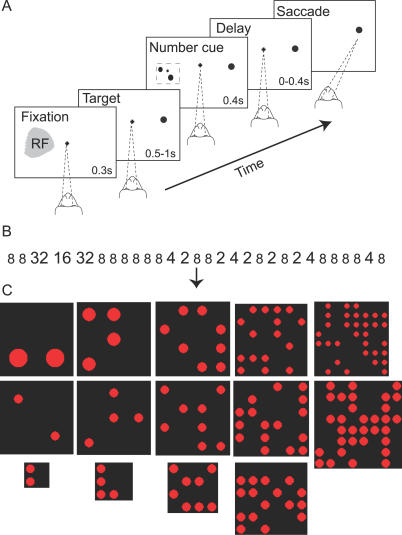
Implicit Numerical Discrimination Task(A) Sequence of trial events. The RF of the LIP neuron is first mapped using a delayed saccade task. Completion of each trial is followed by a fluid reward.(B) Sample trial sequence in which 8 is the standard numerosity and 2, 4, 16, and 32 are deviants. The standard is randomly presented on 50% of trials, and predicts a standard reward (0.1-ml fluid, indicated by smaller digit size). On the other trials, one of the deviant numerosities is shown, predicting a larger reward (0.15-ml fluid, larger digit size). Arrow identifies an example of numerosity that would be presented for an “8” trial.(C) Examples of dot arrays for the numerosities tested: 2, 4, 8, 16, and 32. Stimuli with the same average total number of pixels are in the first row; same radius and overall extent in the second row; and same radius and density in the third row.